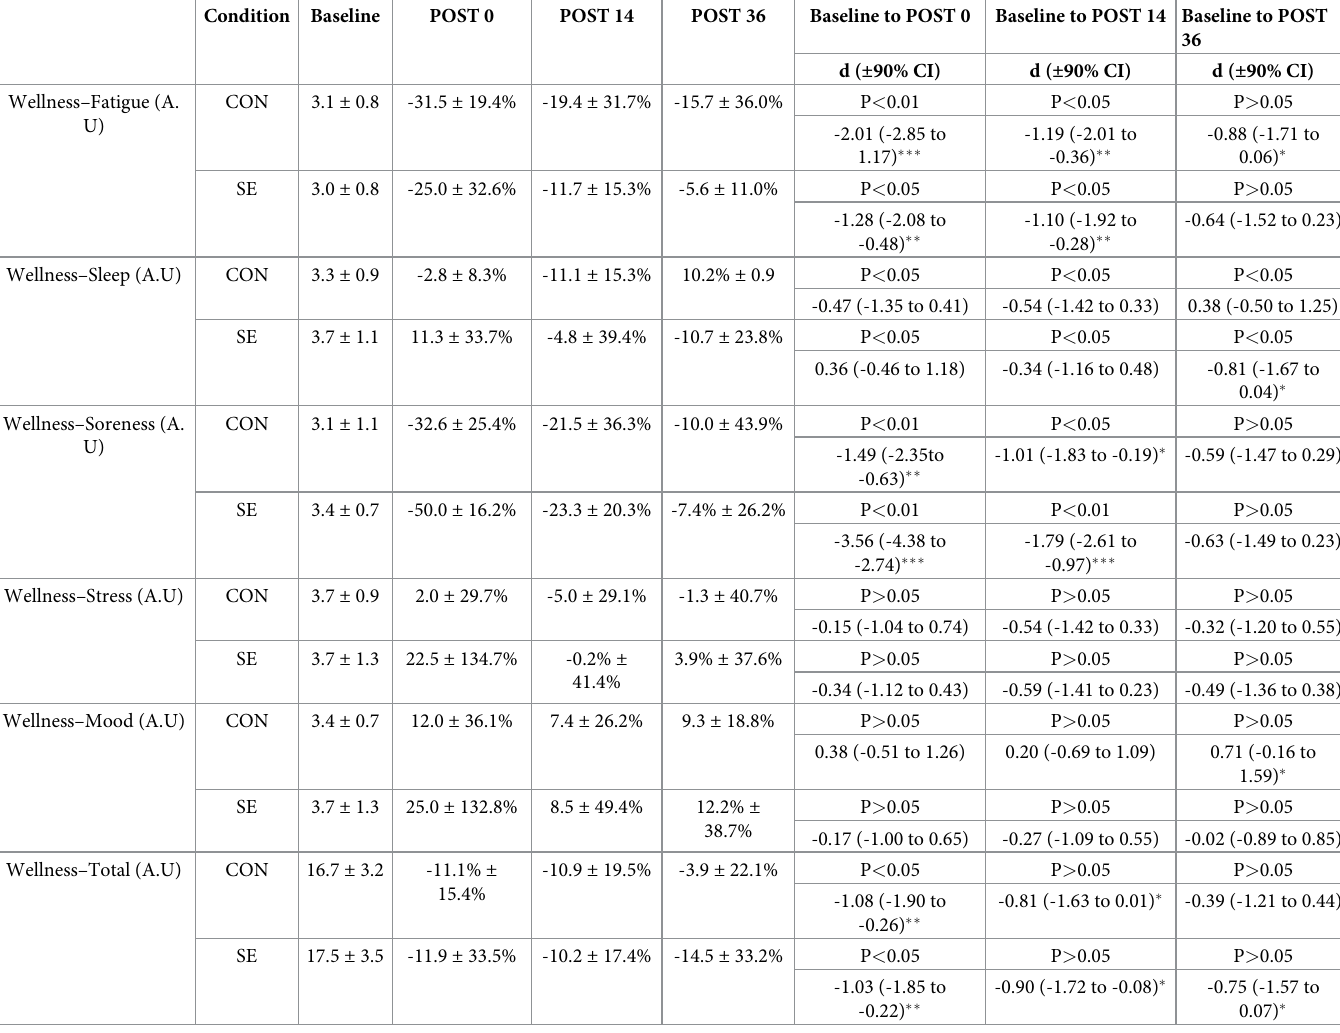
Table 4. Wellness scores change as percentage of